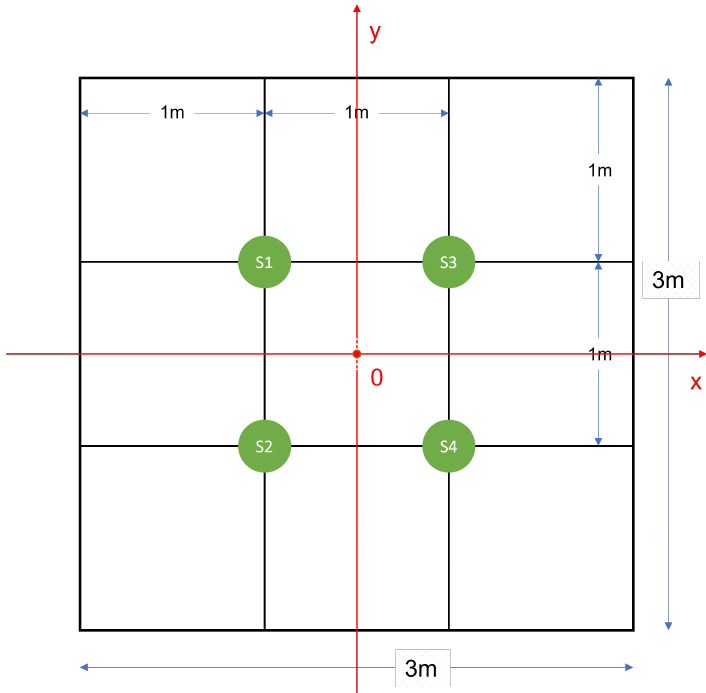
Figure 1. Data acquisition devices and experiment